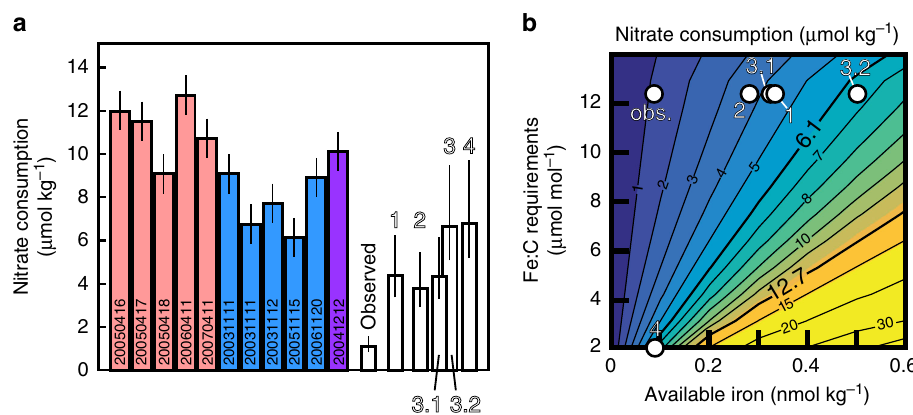
Fig. 2 Observed and potential nitrate consumption. a Nitrate consumption estimates from 2003 to 2007 (colored bars) compared with potential nitrate consumption calculated for Scenarios 1 – 4 (open bars). Nitrate consumption estimates in a are from spring (pink), fall (blue), winter (purple), and error bars are ± 1 μ mol kg − 1 based on source water variability (sampling date at bottom; values in Tables 1 and 2). White columns represent nitrate consumption predicted based on the following scenarios. "Observed" uses iron supply and diatom Fe:C requirements that match local observations 12, 22 . Scenario 1 uses local observations, but with a doubled dust-borne iron supply and an order of magnitude higher solubility of dust-borne iron. Scenario 2 assumes all particulate iron is bioavailable. Scenarios 3.1 and 3.2 use dissolved iron concentrations from 200 m and EUC measurements 3300 km west, respectively. Scenario 4 uses the lowest reported diatom Fe:C requirement of 2 μ mol mol − 1 7 . Error bars (1 standard deviation) allow for potential C:N variability of ± 2 (global community value 71 ) even though phytoplankton community C:N ratio in the eastern equatorial Paci fi c is much smaller ( ± 0.3 10 ). b A sensitivity analysis of potential nitrate consumption based on available iron concentrations and physiological iron requirements. White numbers in b indicate the Scenarios from a , none of which can explain the observed range in nitrate consumption of 6.1 and 12.7 μ mol kg − 1 (bold